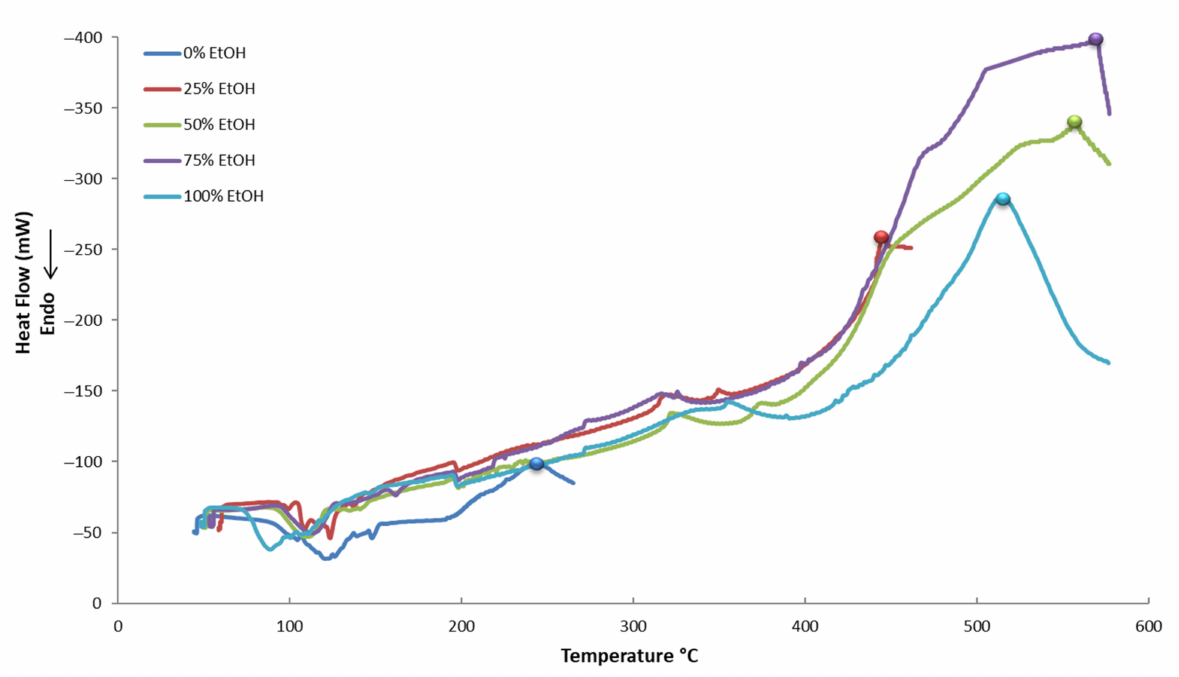
Figure 7. Differential scanning calorimetry (DSC) thermograms of PEF-treated (100 µ s) samples in five different tested